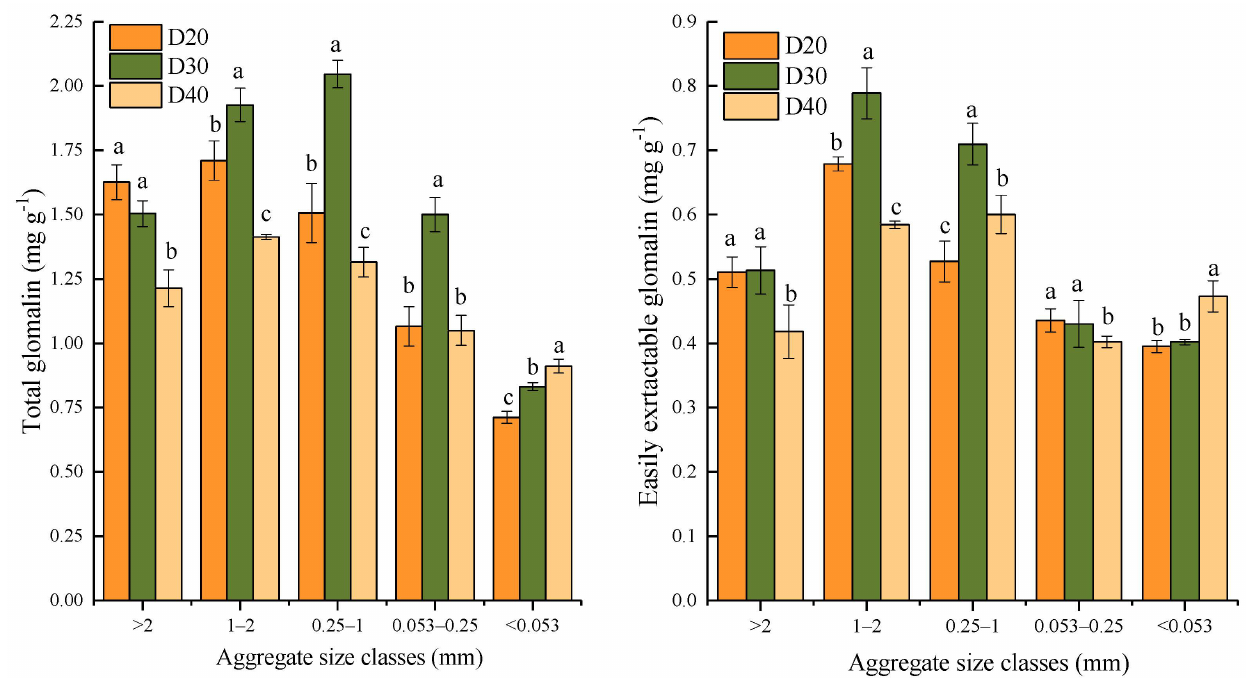
Figure 5. Variation of total glomalin and easily extractable glomalin levels in the aggregates. Note: Different lowercase letters within the same column denote significant differences ( p <